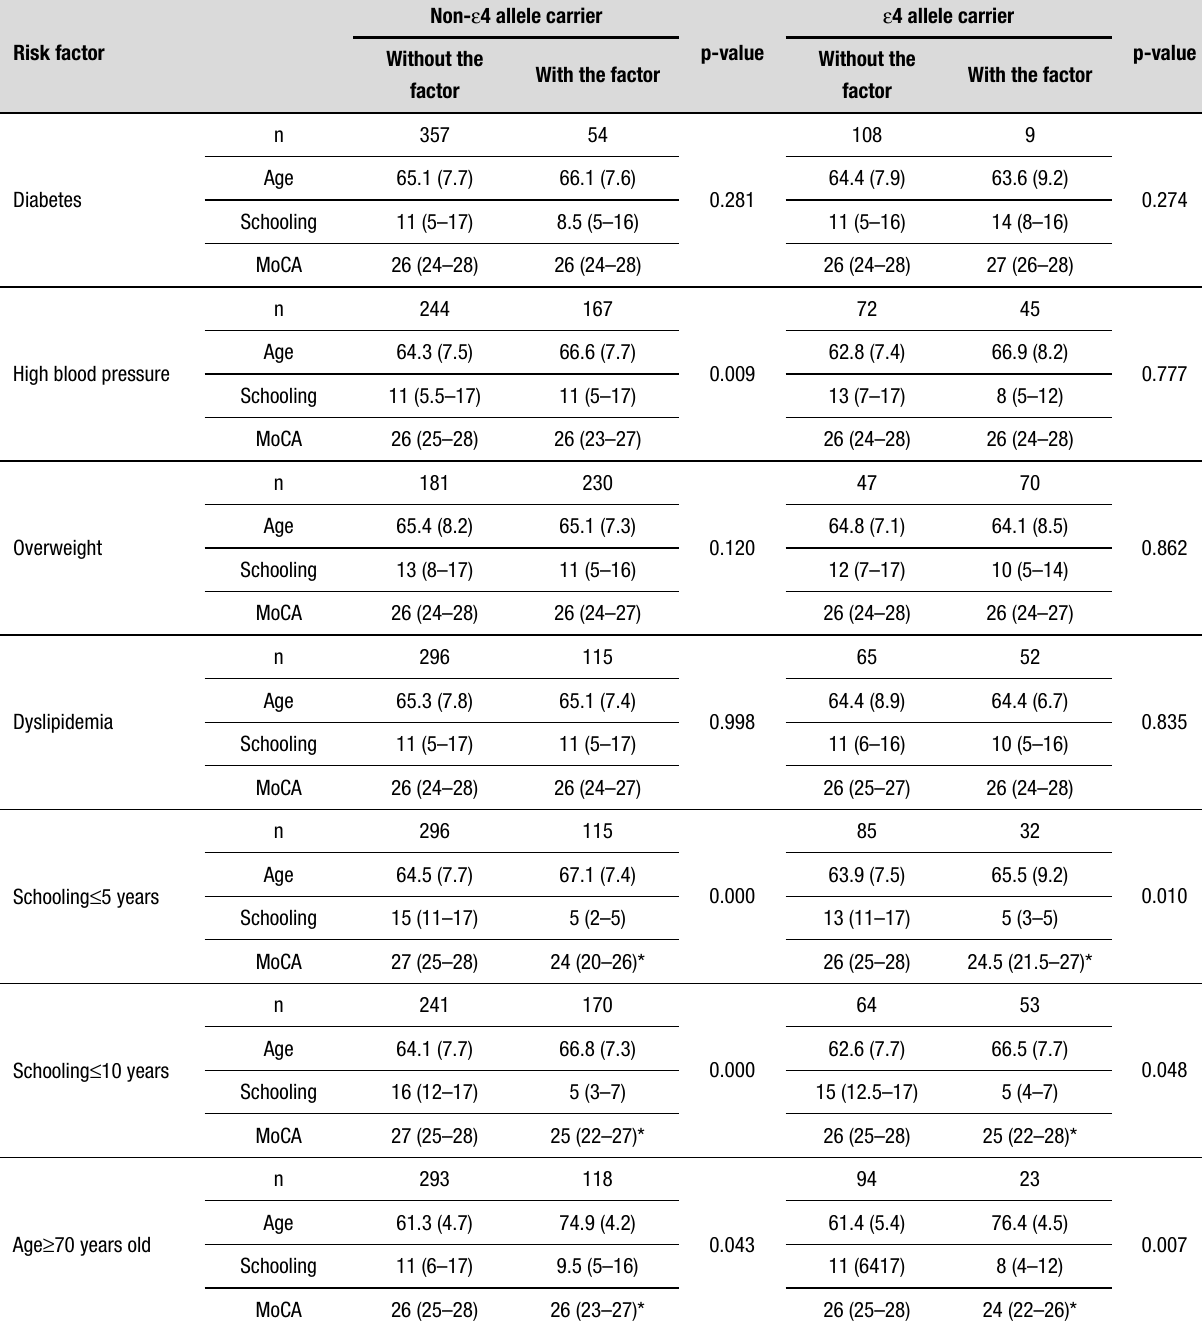
Table 2. Comparison of the Montréal Cognitive Assessment Test, by risk factors, between participants without cognitive impairment (normal), carriers and non-carriers of the allele ε